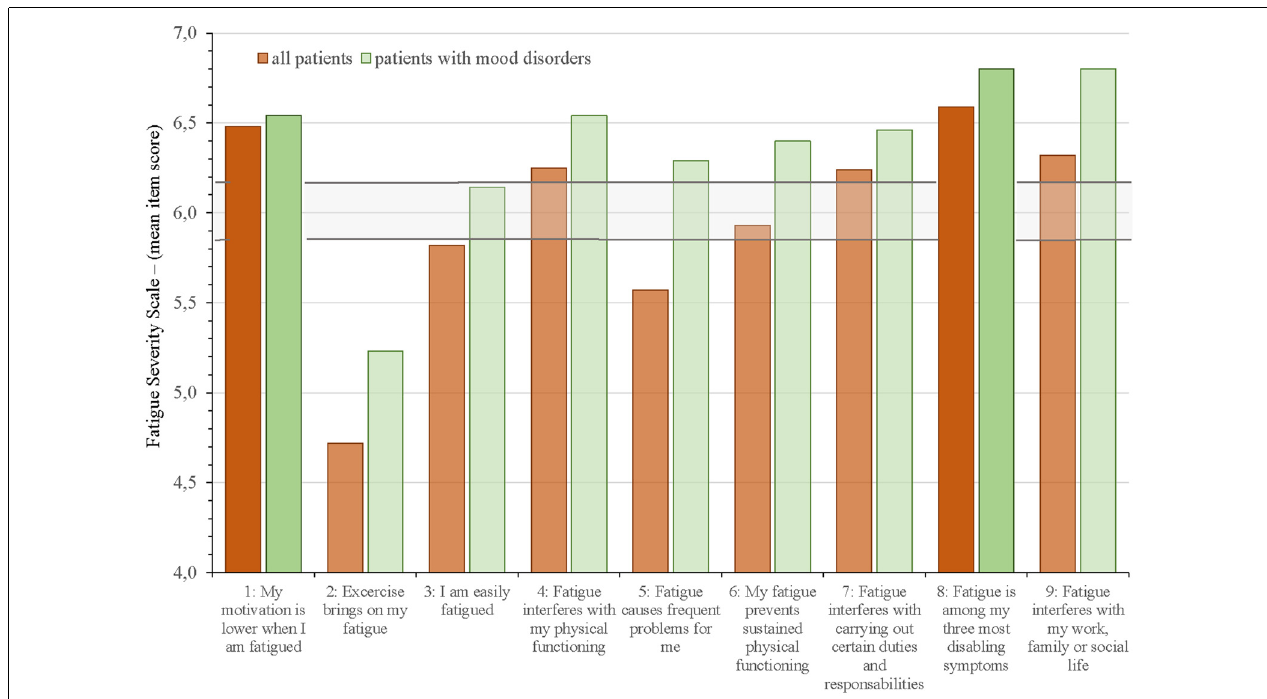
FIGURE 2 | Mean Fatigue Severity Scale (FSS) item scores for all aSAH patients and allocation into subgroup of patients with mood disorders against the mean FSS score ± 2 SEM (horizontal lines). The two FFS items with the highest mean scores are